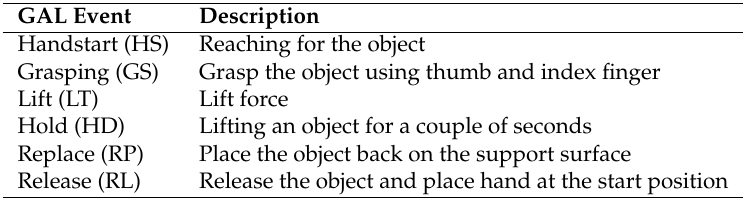
Table 1. Details of six-class grasp-and-lift tasks